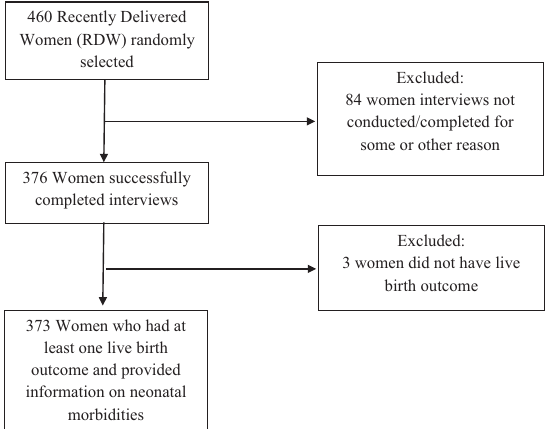
Figure 1. Selection of